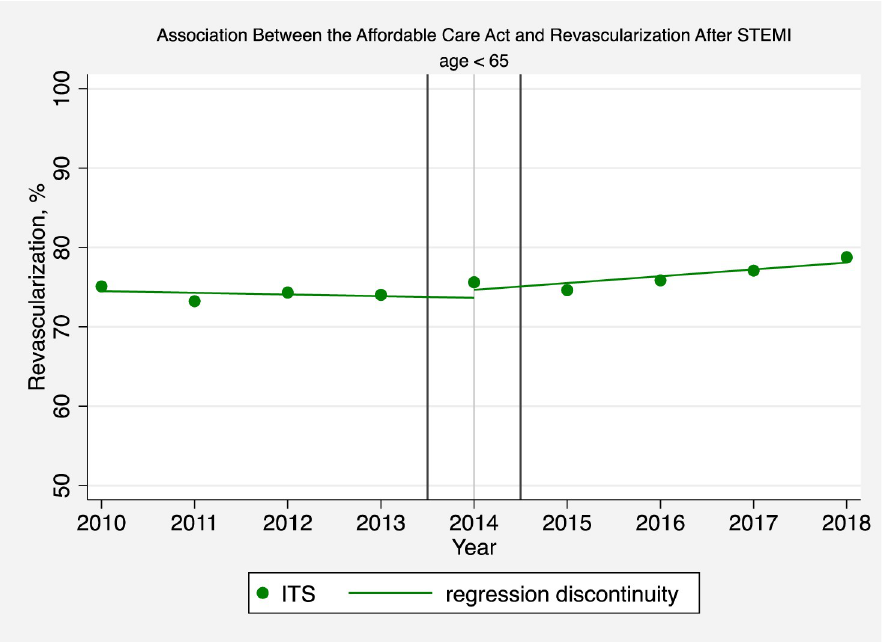
Fig 1. Association between the affordable care act and revascularization after STEMI (age < 65). The solid circles represent the yearly estimates for the revascularization rate in patients hospitalized with a STEMI based on an interrupted time series model after adjusting patient-level and hospital effects, without imposing restrictions on time trends and making no assumptions that time effects were different before or after 2014. The solid line is based instead on a regression discontinuity model which assumes that pre-intervention and post-intervention trends are linear in order to interpret changes in revascularization rates before and after the